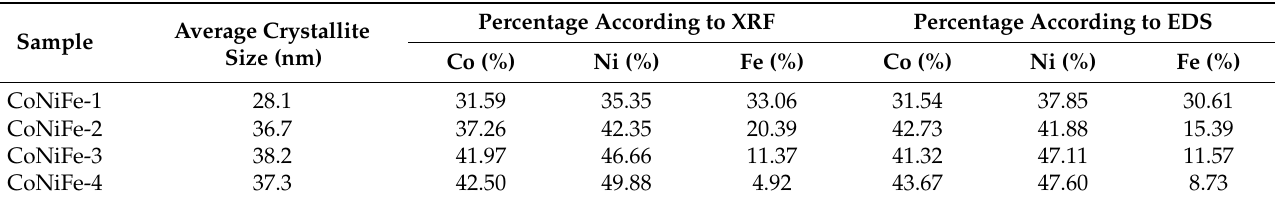
Table 2. Average crystallite size and composition of Co-Ni-Fe oxide